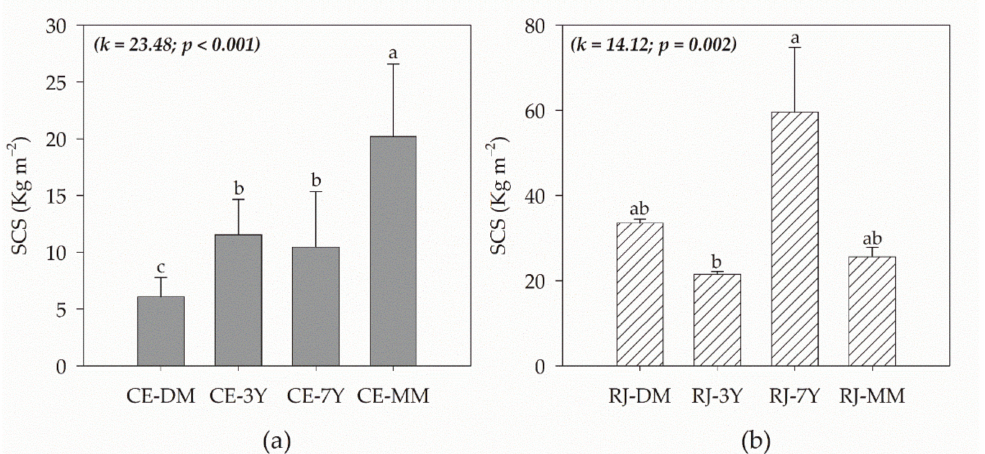
Figure 3. Soil carbon stocks for the different stages of revegetation (DM; 3Y; 7Y; MM) in the Cear á ( a ) and Rio de Janeiro ( b ) mangrove forests. Different lowercase letters indicate significant differences among variables found by the Kruskal–Wallis test at the 5% probability level, and k values above the critical k (7.8147) indicate statistical